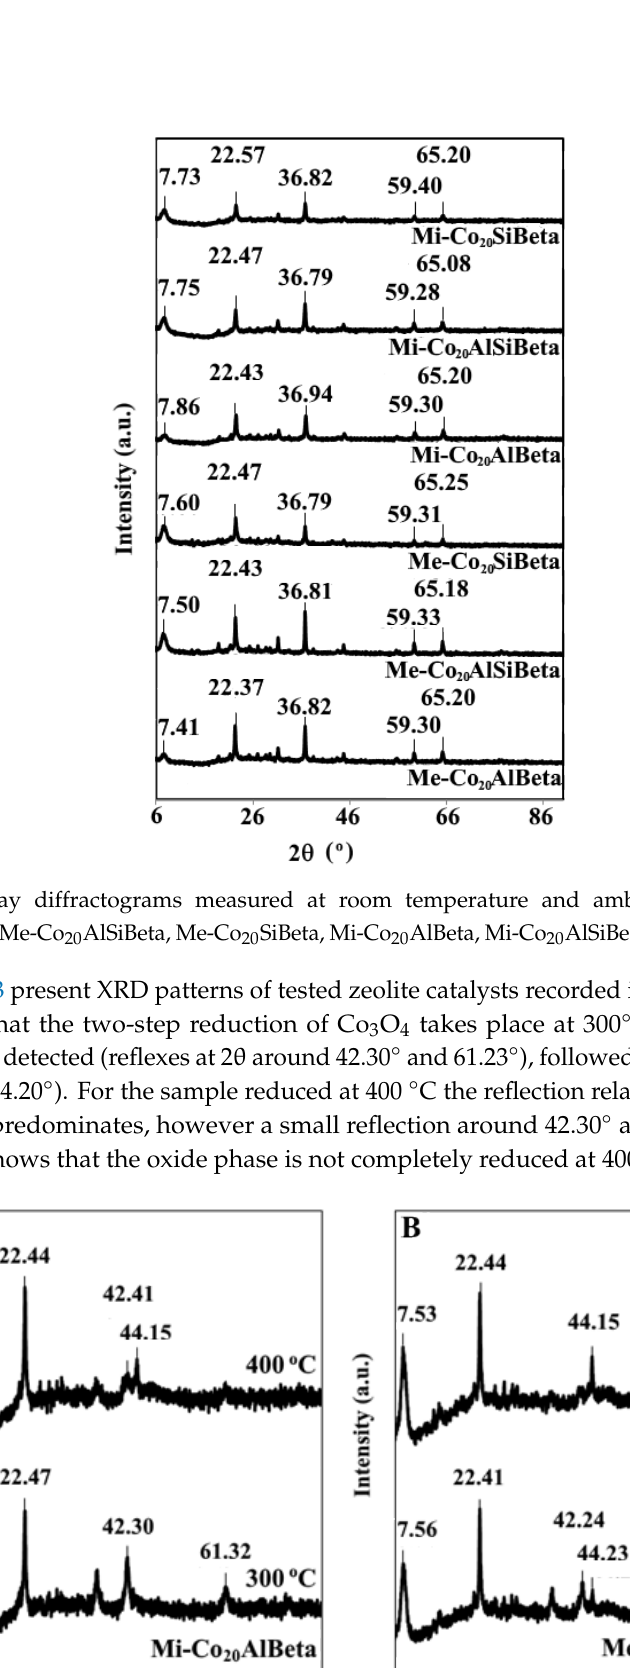
Figure 3. In situ XRD patterns recorded in situ at 300 and 400 o C measured in the atmosphere of the mixture of 5 vol % hydrogen in argon ( A ) Mi-Co 20 SiBeta and ( B ) Me-Co 20 SiBeta. 2.2. Characterisation of zeolite catalysts by XPS The X-ray photoelectron spectra of microporous and mesoporous Co-containing Beta zeolites have been analysed numerically in the BE regions of Si 2p, Al 2p, O 1s, C 1s and Co 2p.